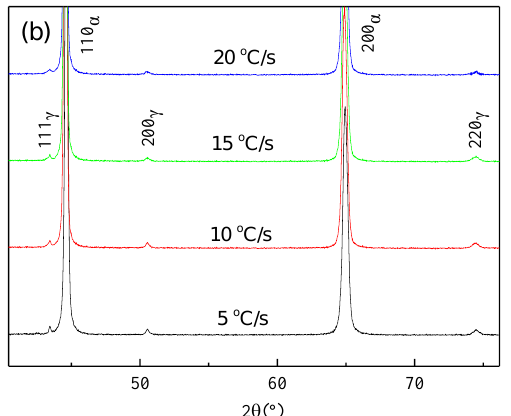
Figure 7. XRD spectra of samples with controlled cooling rate of 5–20 °C/s ( a ); and partial enlarged detail ( b ).